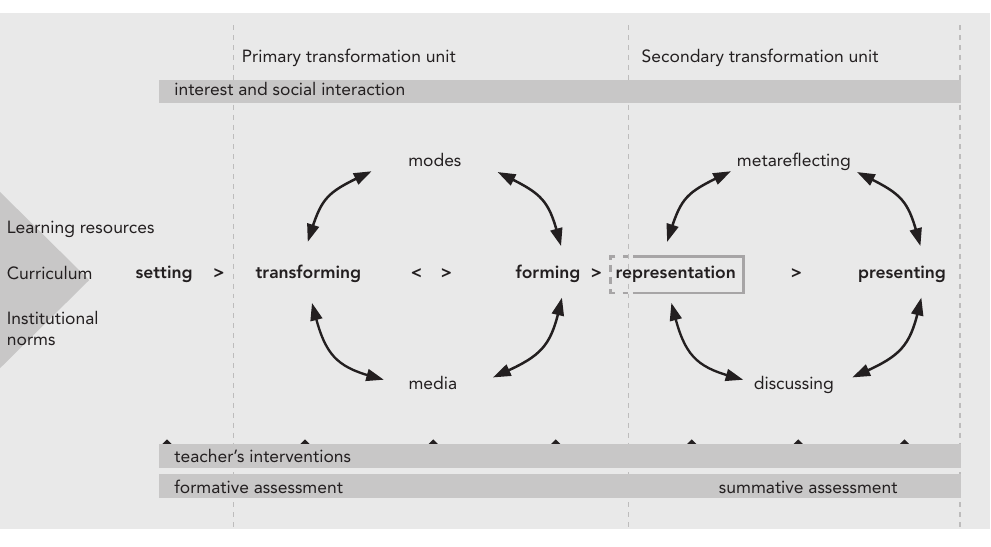
Figure 1: The formal learning design sequence Source : Adapted from Selander (2008: